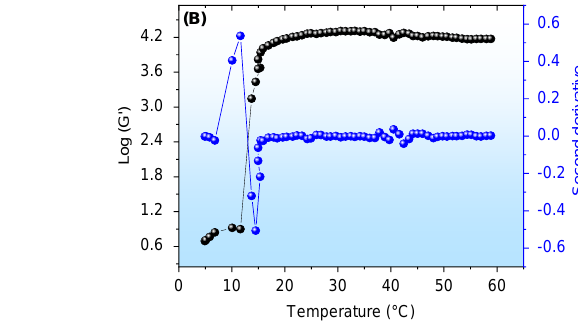
8 of 20 Figure 3. Image of emulgel system at 5 °C and 35 °C and the phase separation representation with micellar dynamics. 3.3. Stimuli-Responsive Properties The thermo-stimulated properties aims to allow the easier administration of the der- matological platform (since it is in a liquid state at low temperatures) and longer perma-